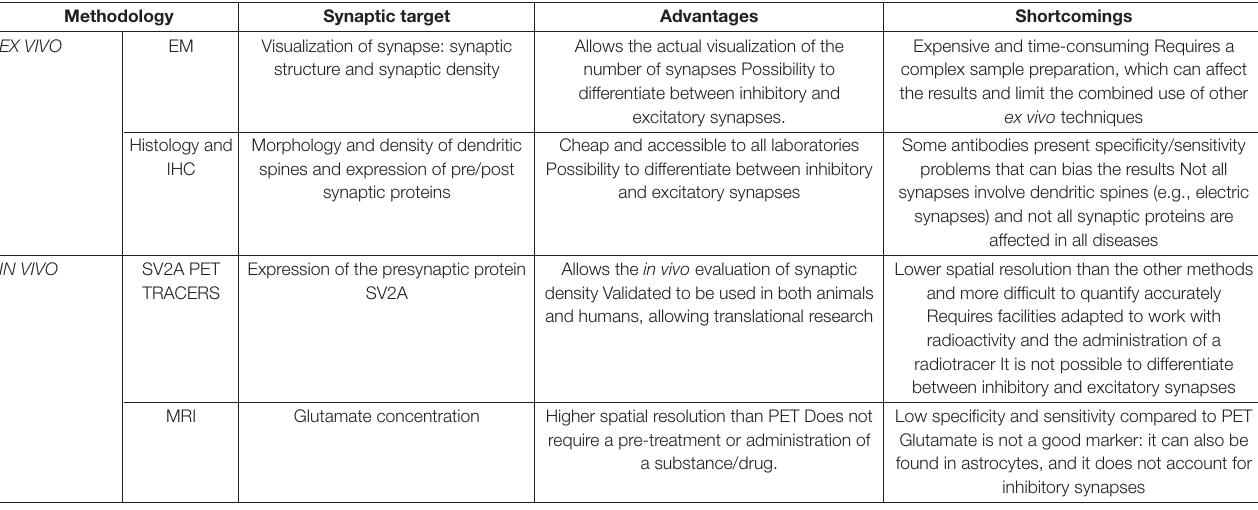
FIGURE 6 | Representative brain images comparing synaptic density and function in the same rat. The images represent the uptake of two radiotracers: (A) [ 18 F]UCB-H (concentration of SV2A protein, synaptic density marker) and (B) [ 18 F]FDG (glucose metabolism, synaptic function marker). Both images were acquired 40-60 min after intravenous radiotracer injection (36 and 20 MBq, respectively). Scans were performed 24h apart, followed by a T2-weighted MR image to allow a better comparison between both PET scans through manual rigid-body co-registration with PMOD software. The white arrows represent the main differences in uptake between both radiotracers. While synaptic density and function are similar in multiple brain areas, regions such as the prefrontal cortex and cerebellum seem to have relatively higher glucose metabolism (synaptic function) than concentration of SV2A (synaptic density). Images obtained at GIGA-CRC in vivo imaging, ULiège (Belgium). TABLE 2 | Summary of main methods for imaging brain synaptic